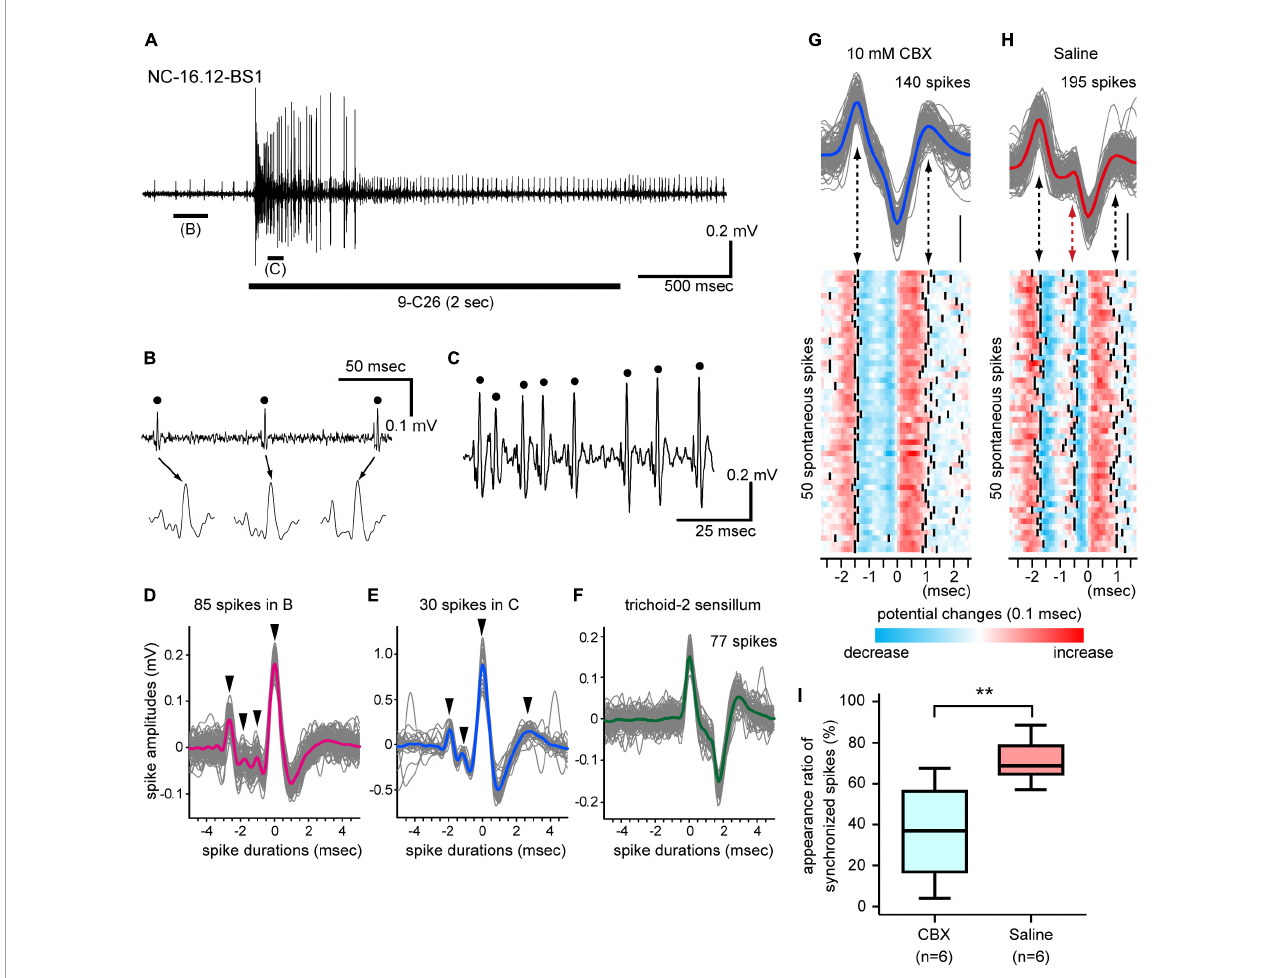
FIGURE3 Synchronized firing of multiple SNs in single basiconic sensilla. (A) Response to 9-C26. A horizontal bar under the electrophysiological trace is the stimulus period. (B,C) Expanded electrophysiological traces shown in panel (A) . Some SNs in a basiconic sensillum exhibit spontaneous spike activity (B) , and the 9-C26 stimulus recruited a different set of SNs (C) . (D,E) Synchronized firing of multiple SNs. Traces of 85 spontaneous spikes [dots in panel (B) ] and 30 CHC-induced spikes [dots in panel (C) ] are superimposed in panels (D,E) , and averaged spike shapes are shown by red and blue lines, respectively. The largest spikes temporally synchronized with several small spikes (arrowheads). (F) Spike shapes of SNs in another olfactory sensillum. Traces of 77 spontaneous spikes of SNs in a trichoid-2 sensillum are superimposed, and averaged spike shapes are shown by a green line. The trichoid-2 sensillum houses 8–9 SNs, but the synchronization of spikes was not observed in the electrophysiological traces. (G,H) Effects of a general gap junction inhibitor on spike activities. Traces of 85 spontaneous spikes from a CBX-injected ant and 195 spikes from a saline injected ant are superimposed in panels (G,H) , and averaged spike shapes are shown as blue and red lines, respectively. Among these spontaneous spikes, 50 typical spikes were arbitrarily selected and are shown as heatmaps. The timing of spike peaks is denoted by solid lines (lower panels). In the saline-injected group, the synchronized spikes are denoted by a red arrow in panel (H) . (I) Appearance ratio of synchronized spikes. Spontaneous spike activities of six basiconic sensilla from 6 CBX-injected ants and six basiconic sensilla from 6 saline-injected ants were recorded. In each recording, the appearance ratio of the synchronized spikes was calculated using spontaneous spikes within the 3-s period of time window. The line in the box and the box represents the median and the quartiles, respectively. The result of the statistical comparison is denoted by asterisks (one-way ANOVA; P <